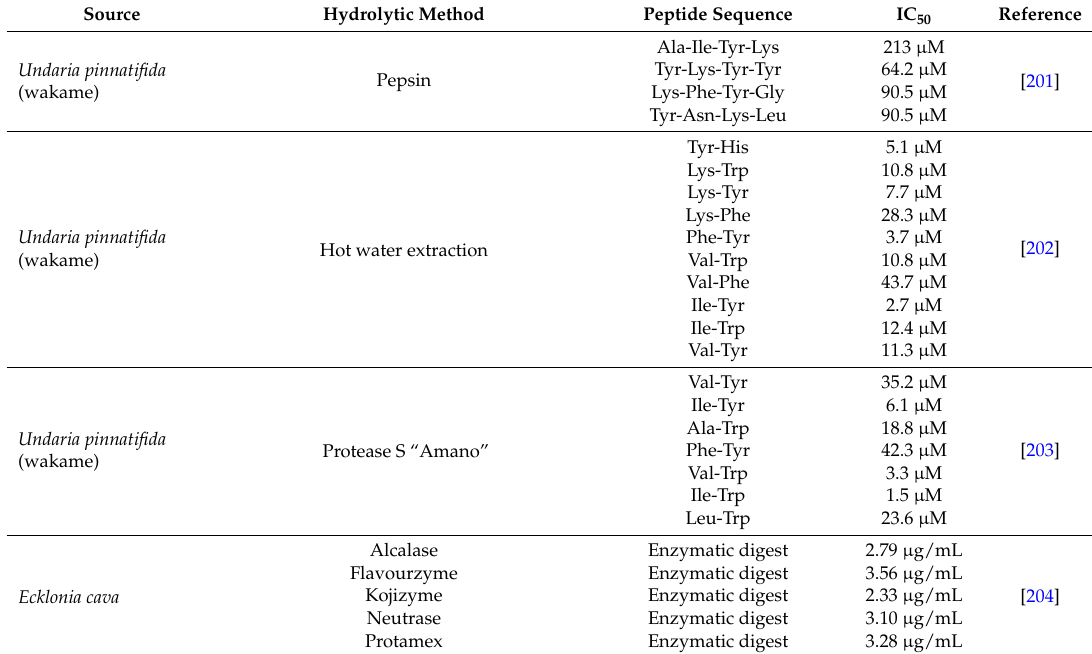
Table 2. Angiotensin-I-converting enzyme (ACE)-I inhibitory bioactive peptides derived from seaweed and microalgae. The potency of the peptides is indicated by their IC 50 values, which refers to the concentration required to inhibit enzyme activity by